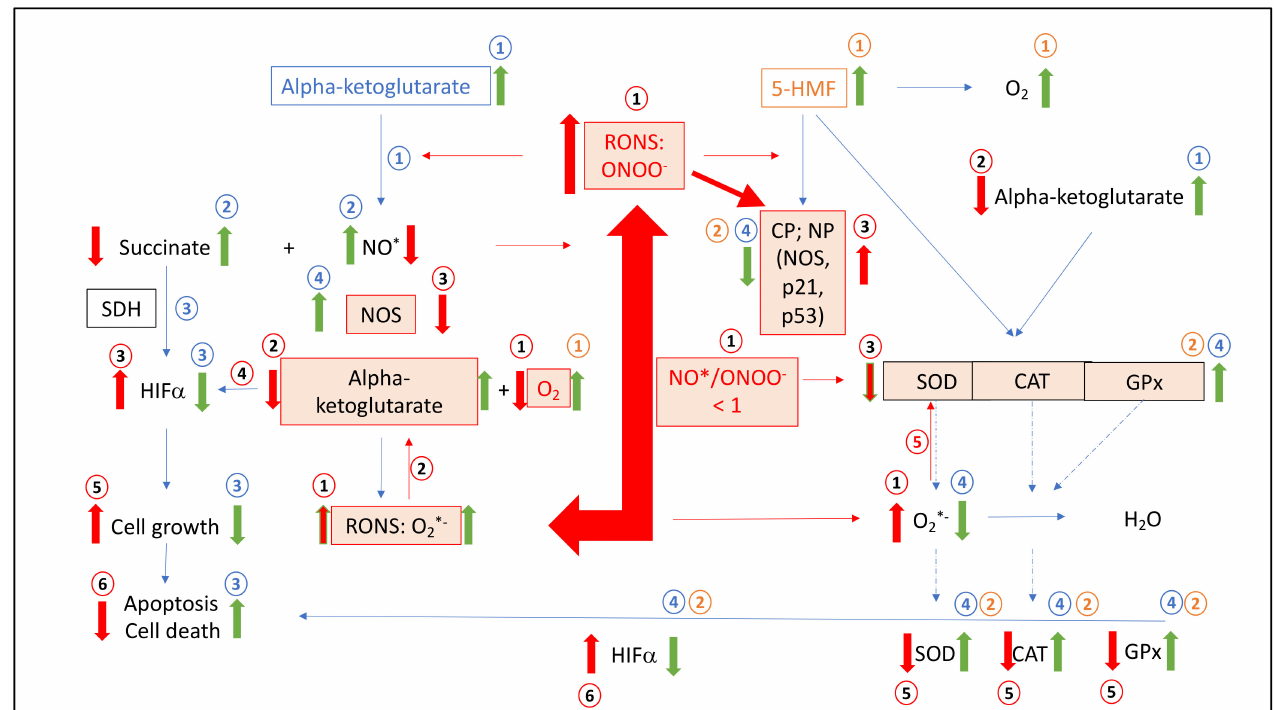
Figure 8. Summary Figure (i) The situation of leukemic cells in the case of RONS and the ratio of NO/ONOO, modified proteins (i.e., HIF α , SDH, SOD, CAT, GPx and NOS), carbohydrates, nucleic acids, alpha-ketoglutarate and cell growth; (ii) Mode of action of alpha-ketoglutarate and 5-HMF added ingredients to leukemic cells to increase apoptosis and cell death via multiple